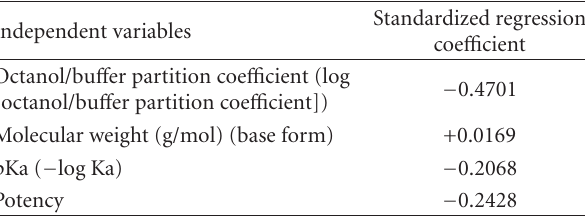
Table 3: Ridge regression analysis using standardized regression coe ffi cients regarding the relationship between the dependent vari- able (representing the local anesthetic concentration eliciting 50% of maximum contraction) and the independent variables (repre- senting physicochemical